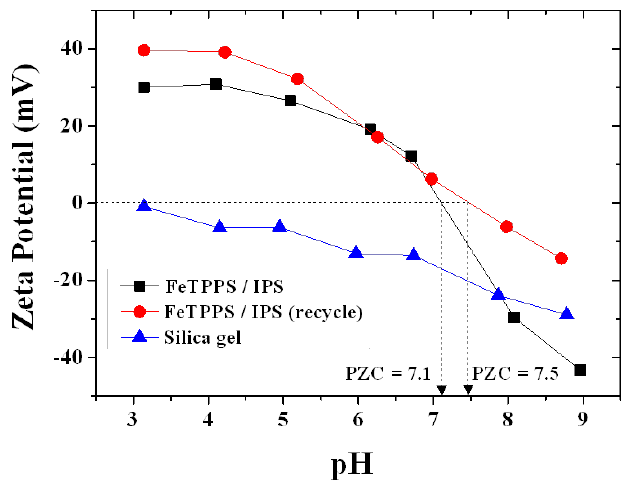
Figure 2. The pH dependence on the Zeta potential for silica, FeTPPS/IPS and the FeTPPS/IPS that was reused 5